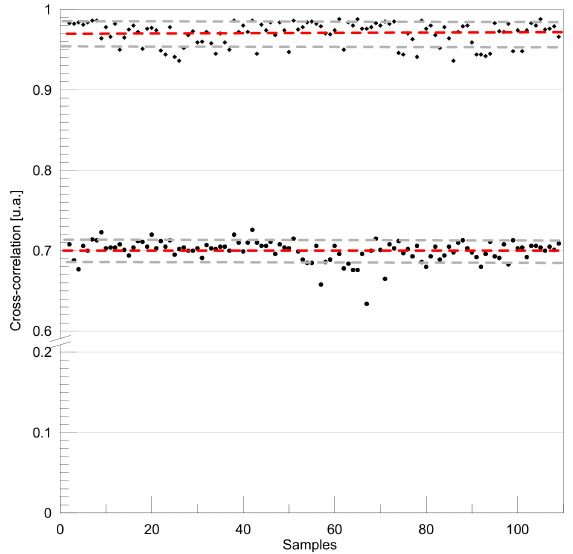
Figure 13. A measurement performed repeatedly hundreds of times on two points, alternating the measurement, manually moving between the two